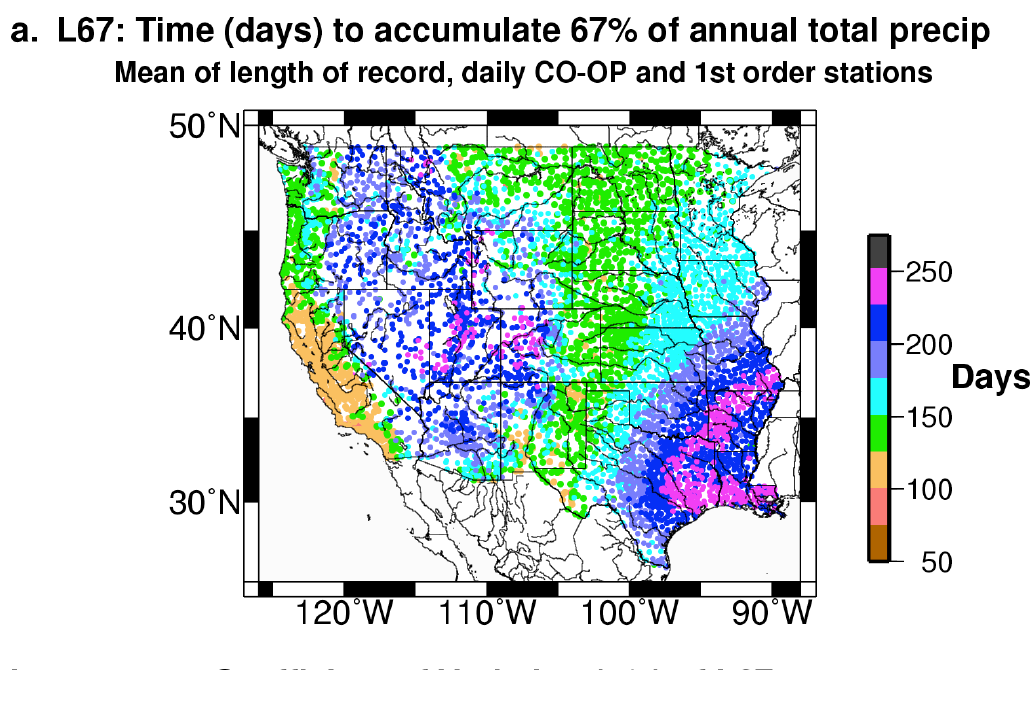
Figure 3. Number of days (L67) required to accumulate 67% of the annual climatological total precipitation, calculated from long-term daily mean precipitation over the period of record available at each station prior to 2000. The beginning of the L67 “season” is the day for which L67 length is at its minimum